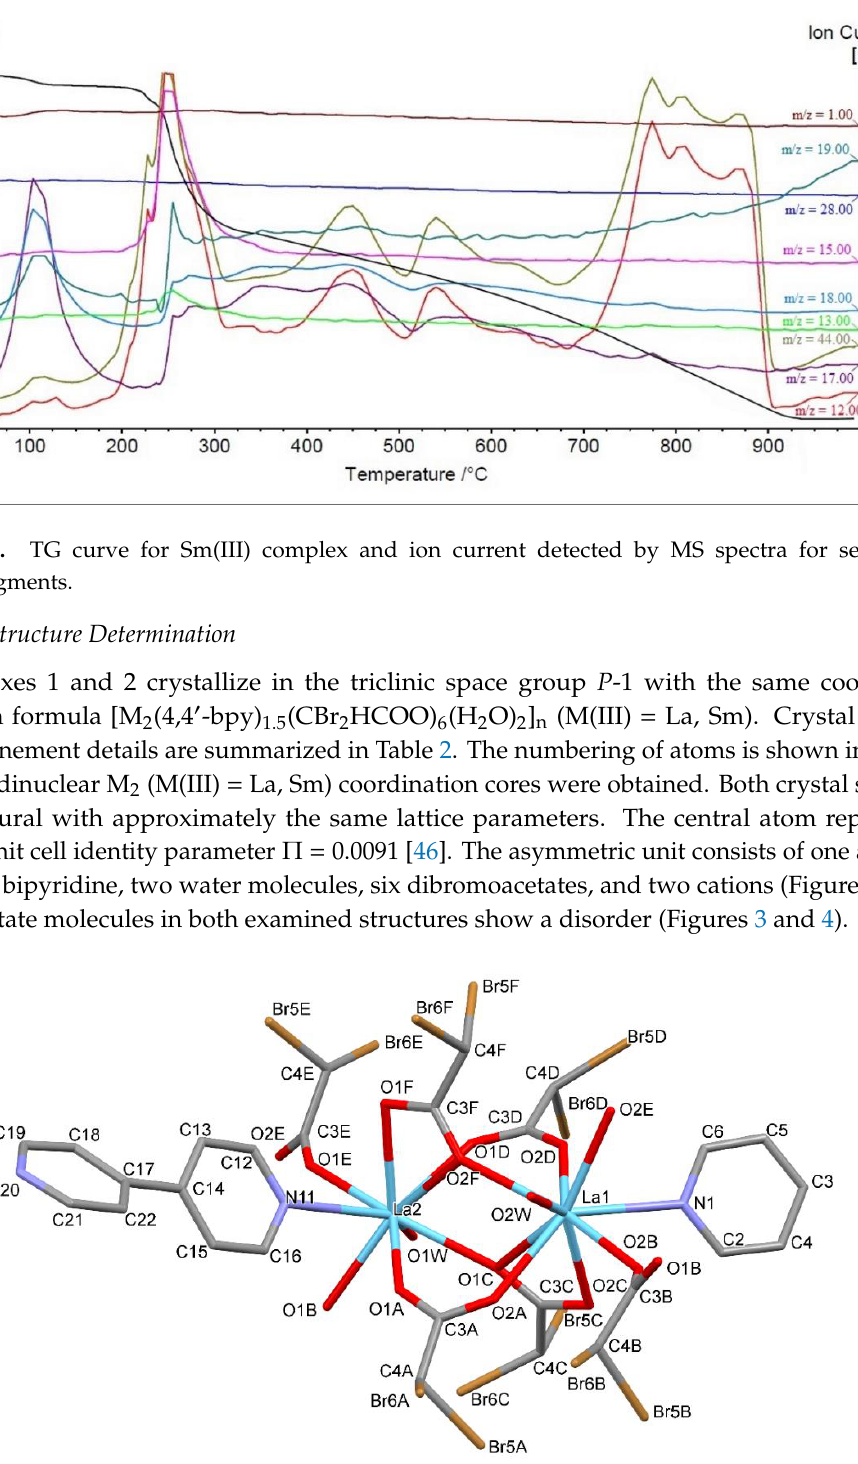
Figure 3. The molecular structure of complex with La(III) (compound 1), the displacement ellipsoids are drawn at the 50% probability level except H atoms. Figure 4. The molecular structure of the complex with Sm(III) (compound 2), the displacement ellipsoids are drawn at the 50% probability level except H atoms.